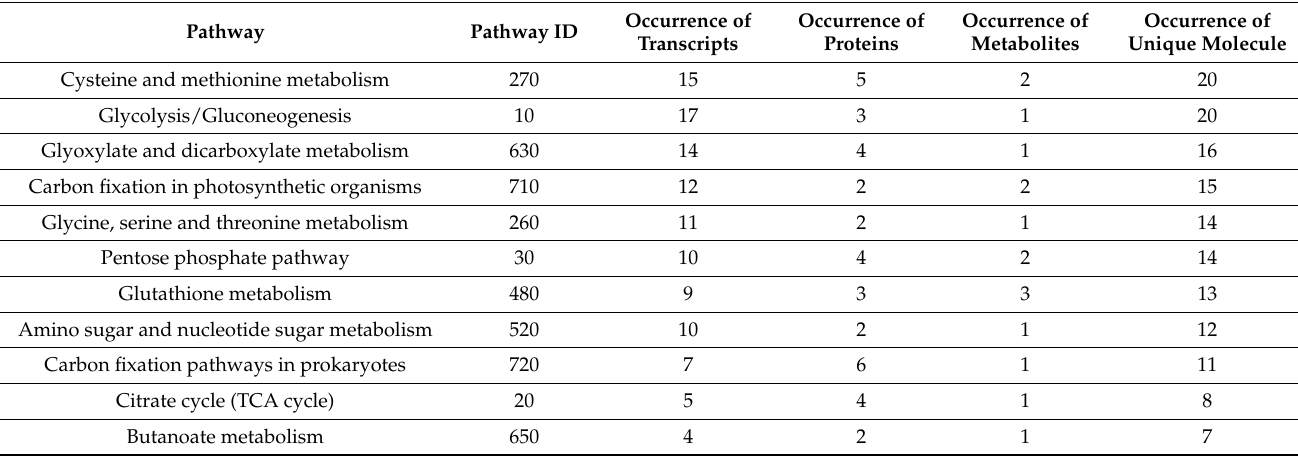
Table 5. List of top eleven pathways affected by salinity stress obtained via Multi-Omics Integration (MOI). Transcriptomics, proteomics, and metabolomics data from leaves of young oil palm plants after being under 0.0 (control) and 2.0 (stressed) g of NaCl/100 g of substrate for 12 days. Occurrence of Occurrence of Occurrence of Occurrence of Pathway Pathway ID Transcripts Proteins Metabolites Unique Molecule 270 15